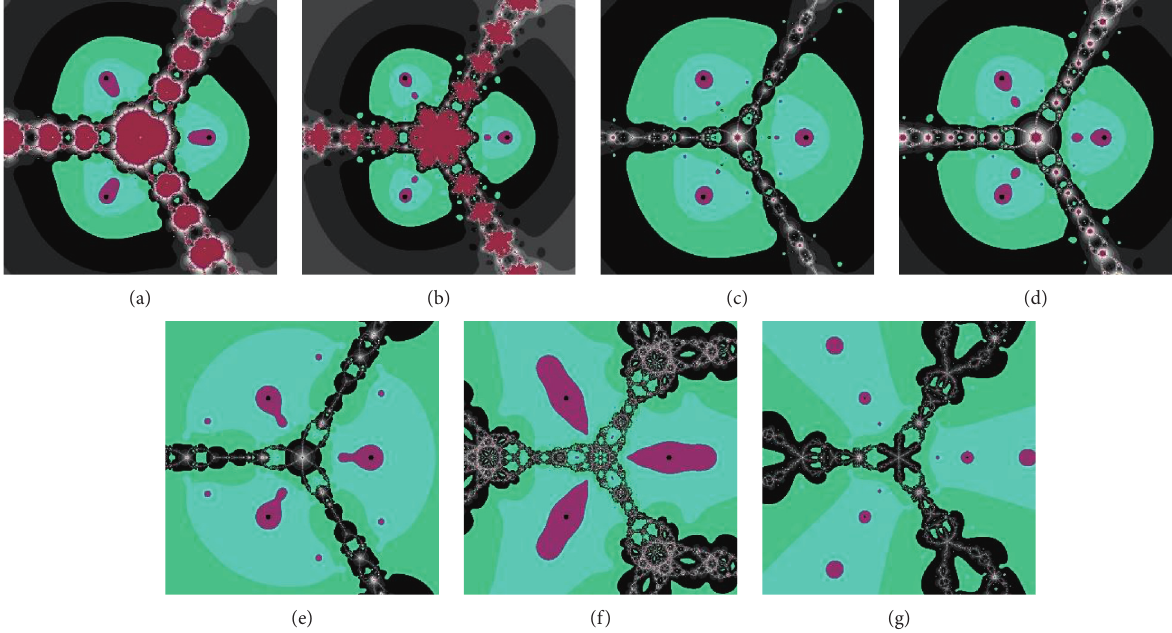
Figure 4: Polynomiographs for the polynomial p NR1. (b) Polynomiograph for the polynomial p